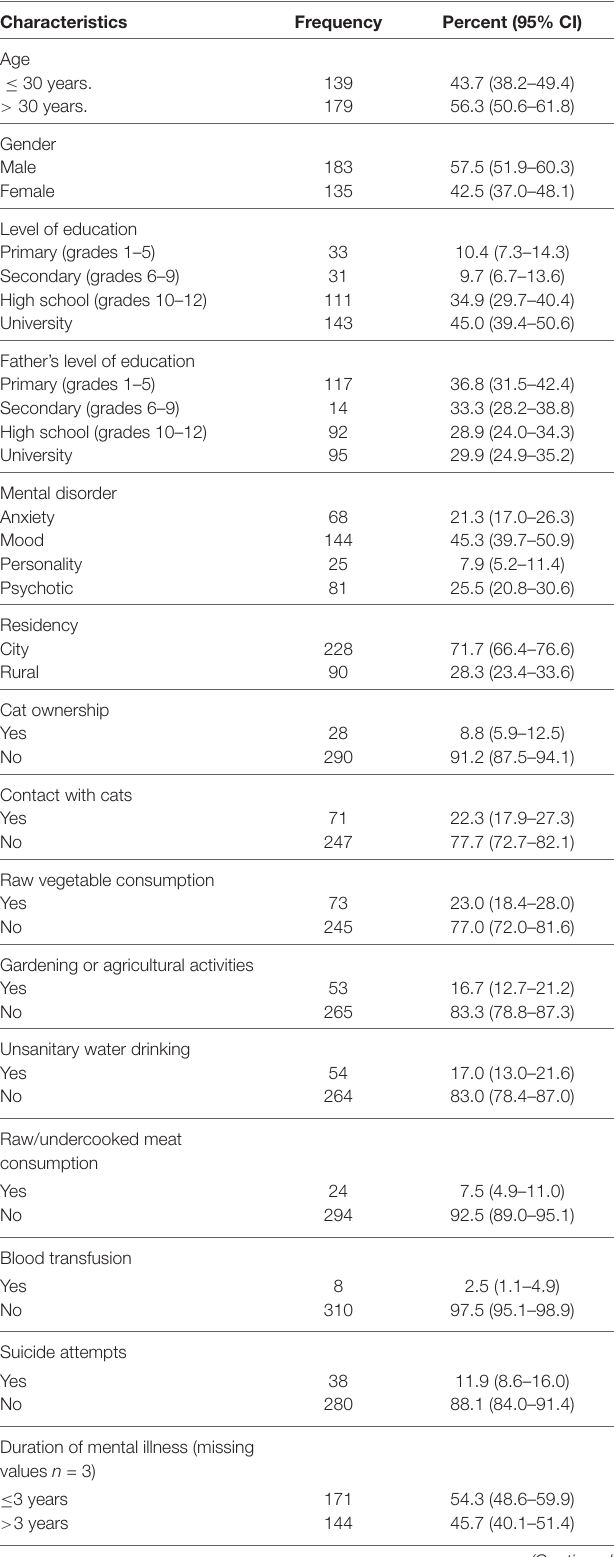
TABLE 1 | Demographic characteristics and risk factors linked to seroprevalence of T. gondii in 318 psychiatric patients.